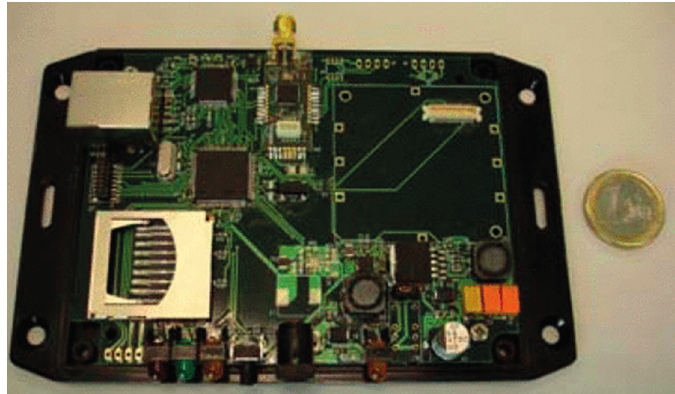
Figure 4. Sink node. General